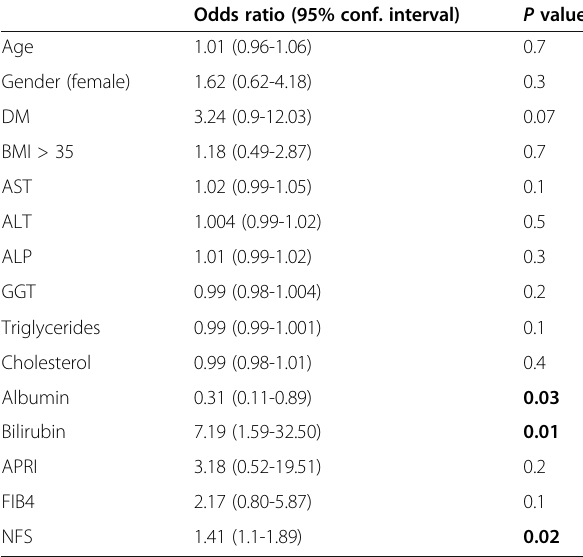
Table 2 Univariate logistic regression analysis for factors associated with significant fibrosis ≥ F2 in NAFLD patients Odds ratio (95% conf. interval)